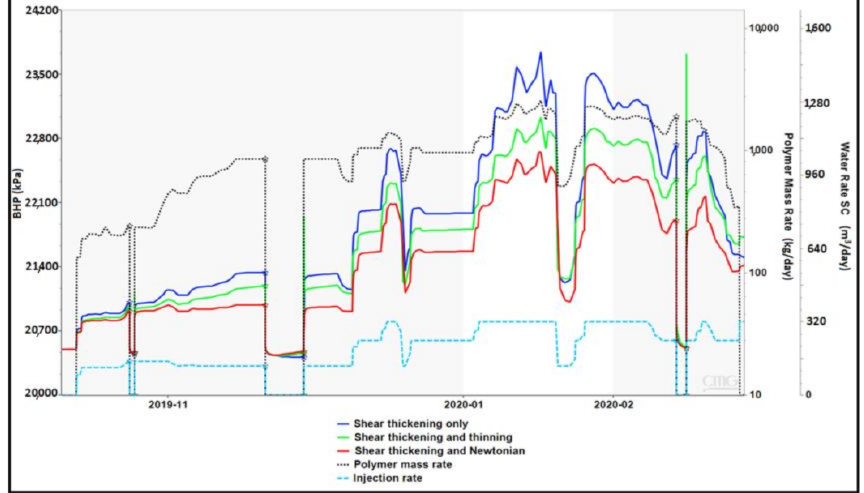
Figure 21. BHP response of the shear thickening cases using actual field rates and